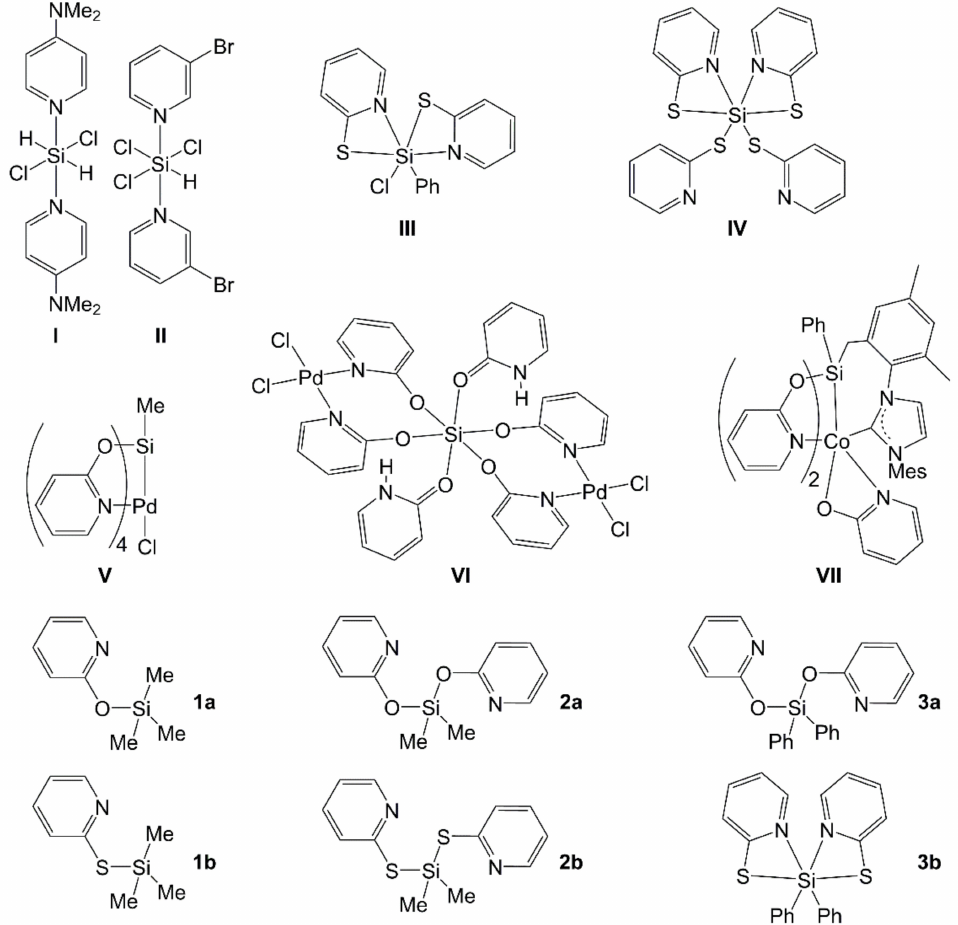
Figure 1. Selected higher-coordinate silicon compounds with pyridine derivatives ( I – VII ) and compounds 1a , 1b , 2a , 2b , 3a and 3b studied in the current